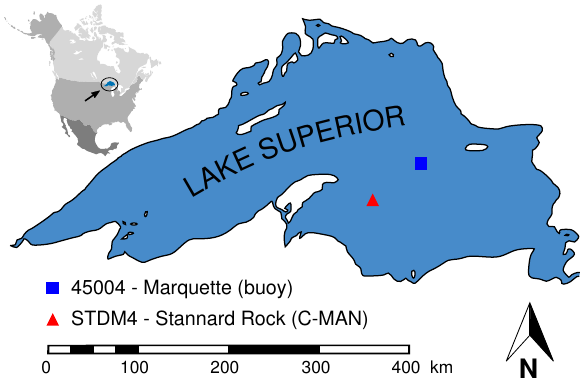
Fig. 3. Lake Superior with the location of the NDBC stations (45004 – Marquette and STDM4 – Stannard Rock) used in this work. The inset shows the location of lake Superior in North America.